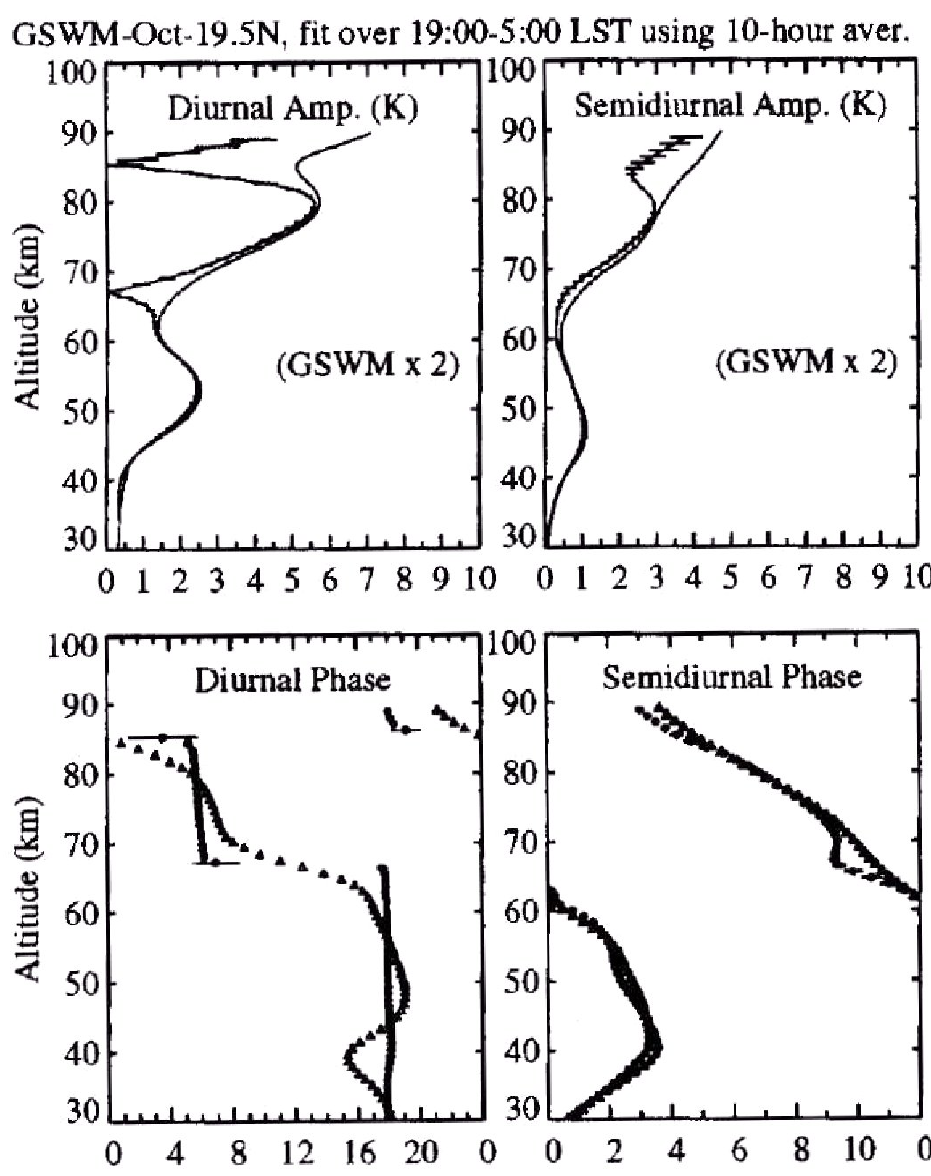
Fig. 7. Comparison between temperature tides observed by Rayleigh lidar at Mauna Loa (19.5 ◦ N) with the GSWM model (after Leblanc et al.,